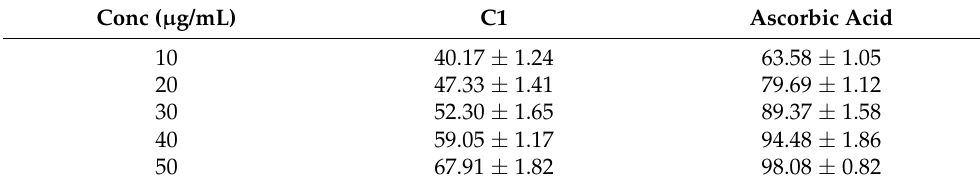
Table 8. Fe 2+ ion chelation ability activity of